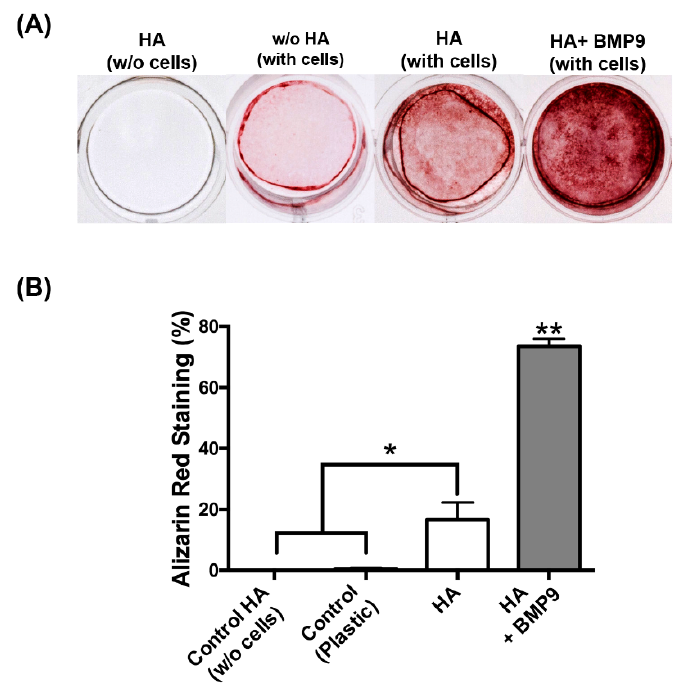
Figure 6. ( A ) Visual representation of alizarin red stained of (1) negative control HA without cells, (2) control tissue culture plastic (TCP), (3) control HA and (4) HA in combination with 100 ng/mL of rhBMP9 at 14 days post-seeding. Note the intensity of red staining on HA scaffolds with BMP9 in comparison to control TCP and HA alone groups. ( B ) Quantified data of alizarin red staining from color thresholding software (* denotes significant difference, p < 0.05; ** denotes significantly higher than all other treatment modalities, p < 0.05).